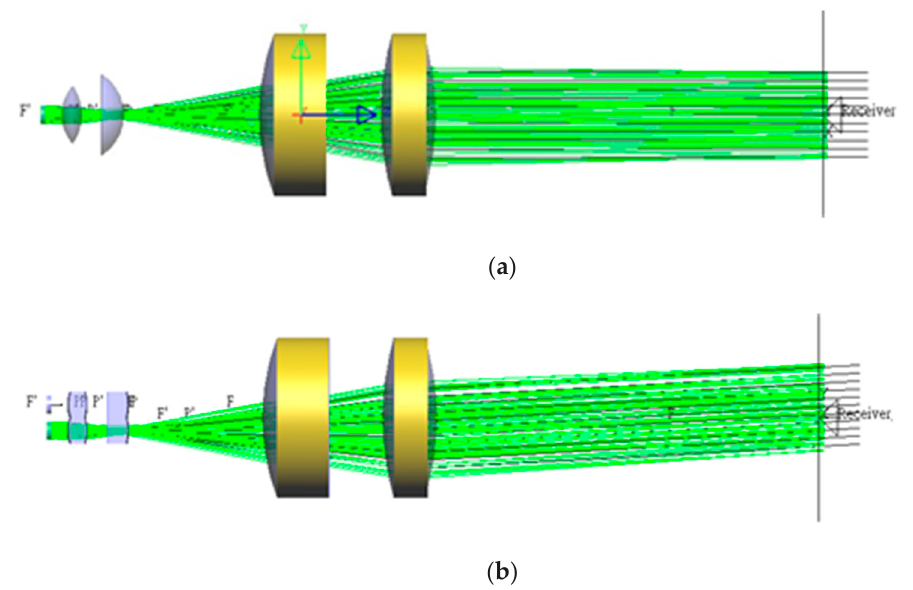
Figure 5. ( a ) Paraxial optical path design, similar to rectangular telecentric optical design. ( b ) Light source off-axis 2 × 2 array design (No laser diode on the main axis, and four light sources were symmetrically located in alignment with the main axis).